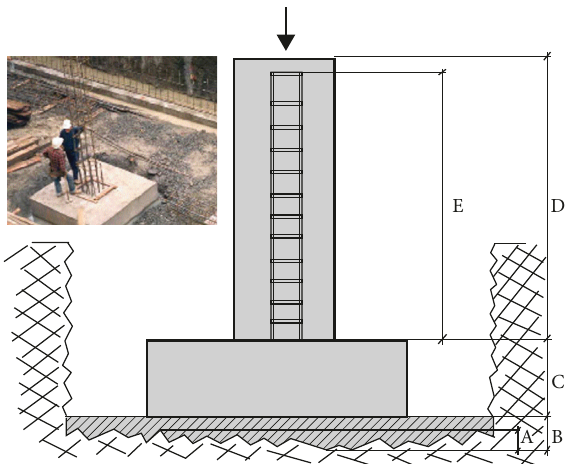
Figure 1: A scheme of pillar construction combined with the photo of the real